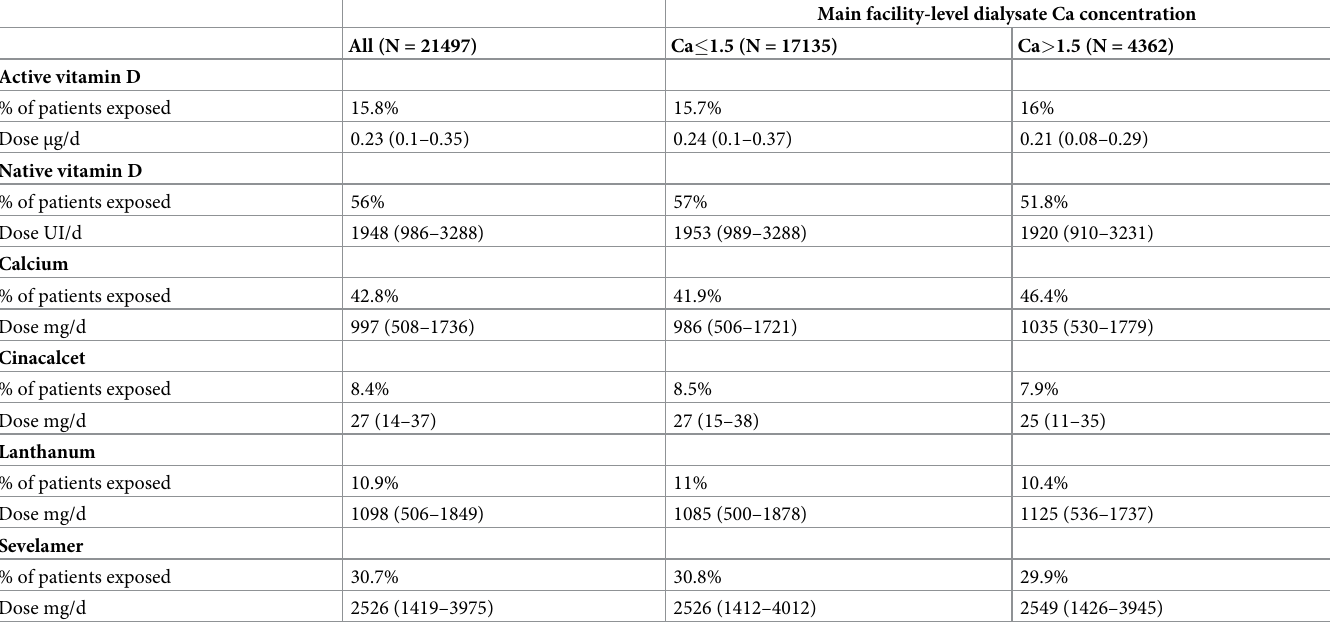
Table 4. First-year medication prescriptions as a function of the primary facility-level dialysate calcium concentration at baseline, for the 21497 patients identified in the French national health